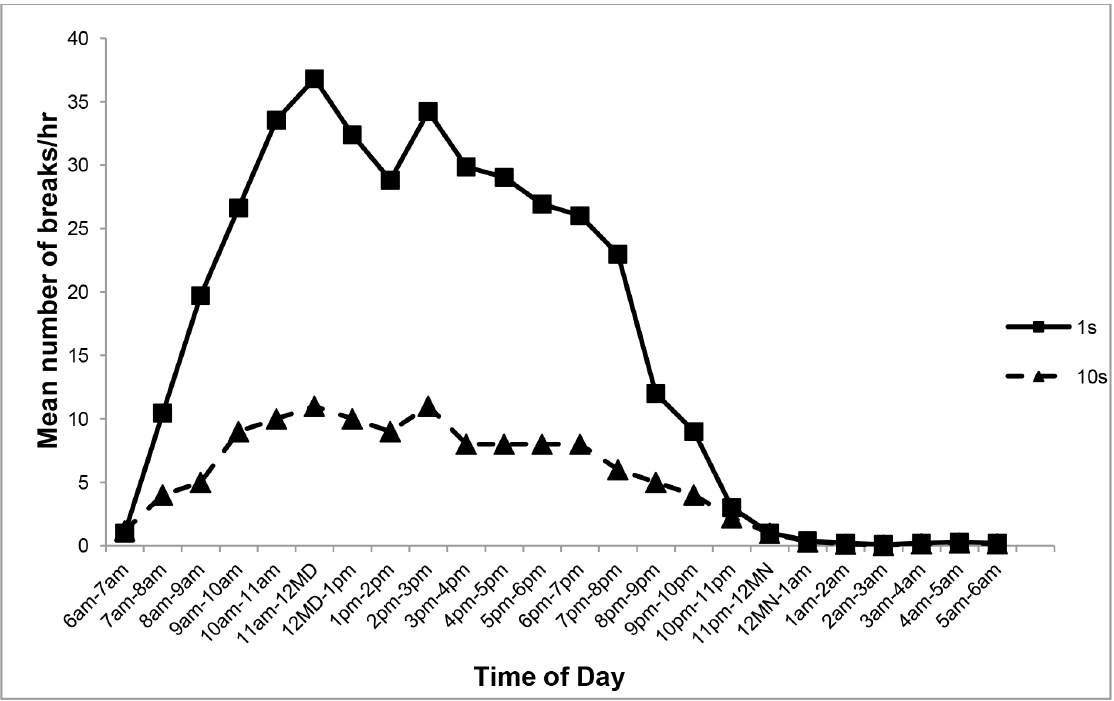
Figure 1. The mean number of breaks in sitting/hr during 24 hr using minimum time to define new position settings of 10 s and 1 s. Study 1(n=20). doi:10.1371/journal.pone.0071854.g001 activPAL TM sitting/upright period of 10 s, the mean (SD)